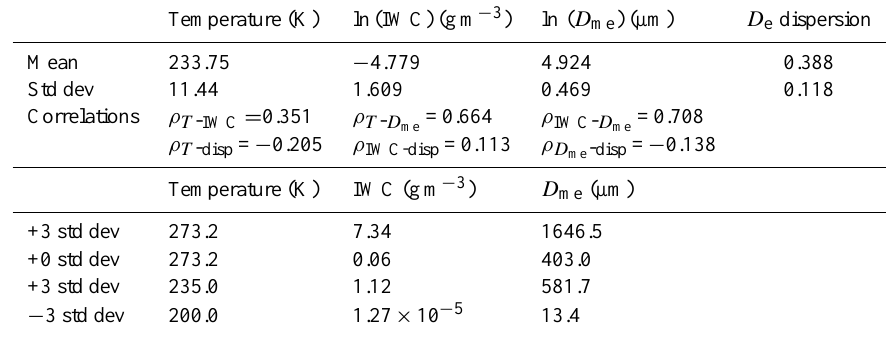
Table A1. Ice particle microphysical statistics defining the a priori Gaussian probability